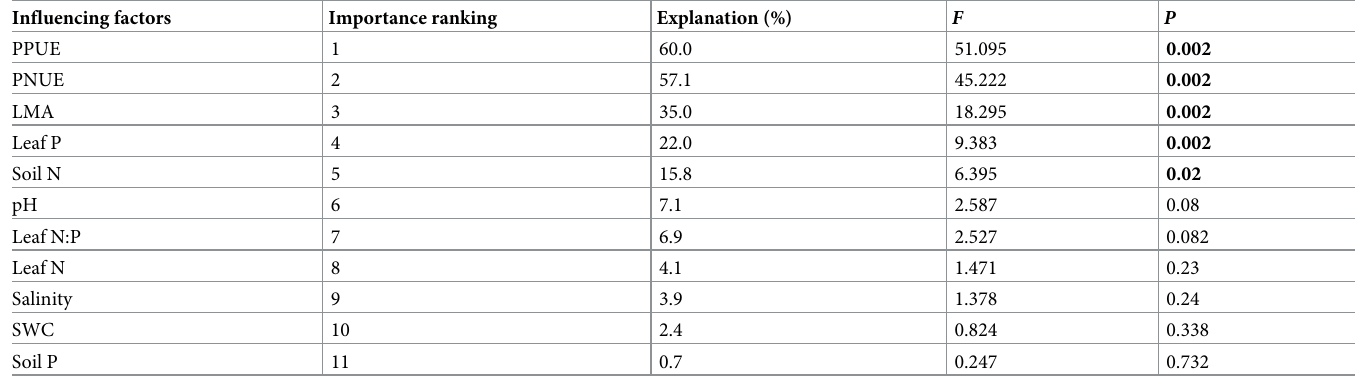
Table 3. Importance ranking and significance of influencing factors in their explanation on the gas exchange capacity of halophytic plant communities. Influencing